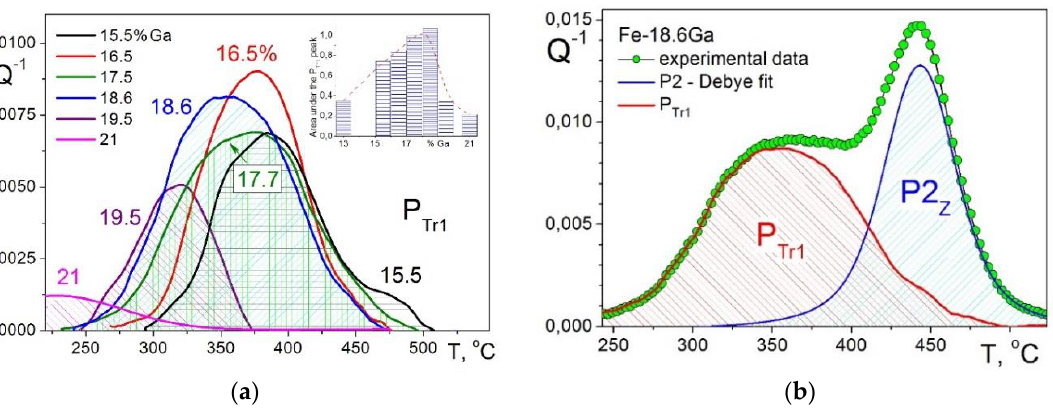
Figure 8. Transient peak P Tr1 in water quenched Fe–(16–21)%Ga alloys: inset—area under the peak ( a ), method of deconvolution via fitting P2 Z peak ( b ).